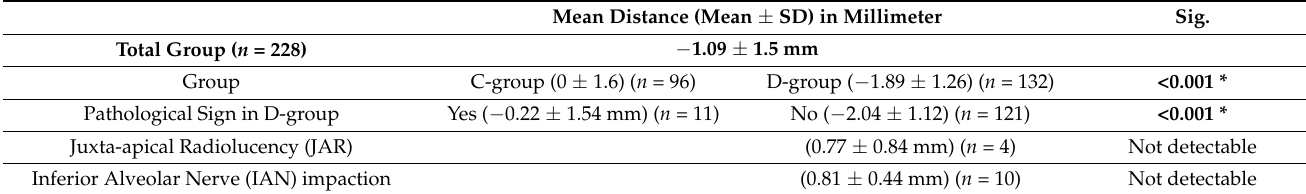
Table 2. Mean distance across the study groups. SD = standard deviation, Sig = statistical signifi- cance using One-way ANOVA and T-test. *= p value with significance level.